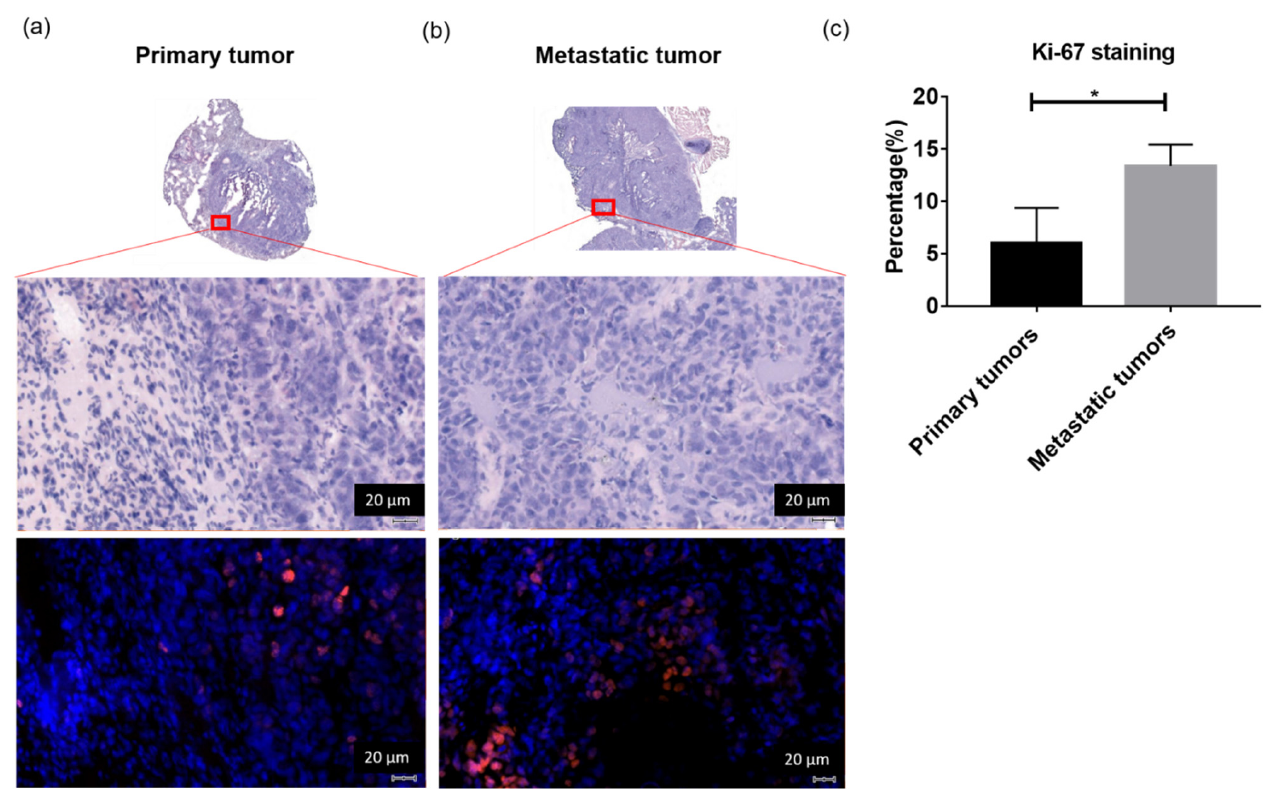
Figure 5. Metastatic tumors showed a higher proliferation rate compared with primary tumors that are from the localized group. ( a ) Representative HE-stained sections of primary tumors infiltrated by cells with large nuclei corresponding to Ki67-stained and DAPI-stained sections of primary tumors (×200, scale bars 20 μ m). ( b ) Representative HE-stained sections of metastatic tumors with disturbed cells corresponding to Ki67-stained and DAPI-stained sections of metastatic tumors (× 200, scale bars 20 μ m). ( c ) The quantitative expression of fluorescent Ki-67 of metastatic tumors is significantly increased compared to that of primary lung tumors (primary tumors 6.052 ± 1.934% vs. metastatic tumors 13.41 ± 1.184%, N = 3 for each group, * p < 0.05).